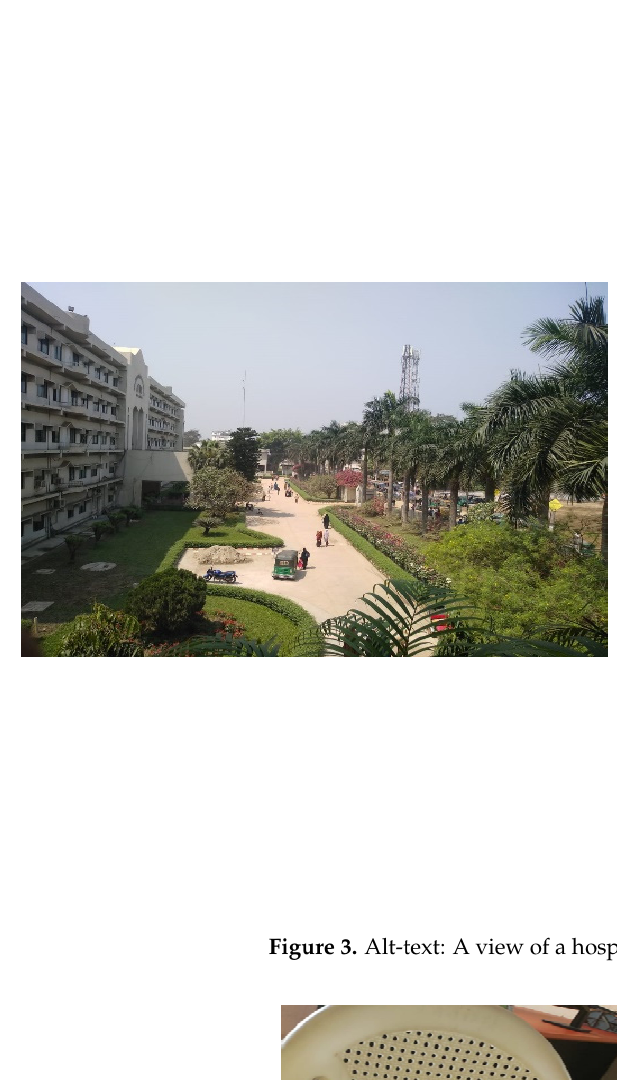
Figure 5. Alt-text: Young man sitting on a white tiled floor, using his foot to operate his phone. Figure 6. Alt-text: Members of Cultivation for Users Hope, three women and a man, standing together smiling in front of planted trees.